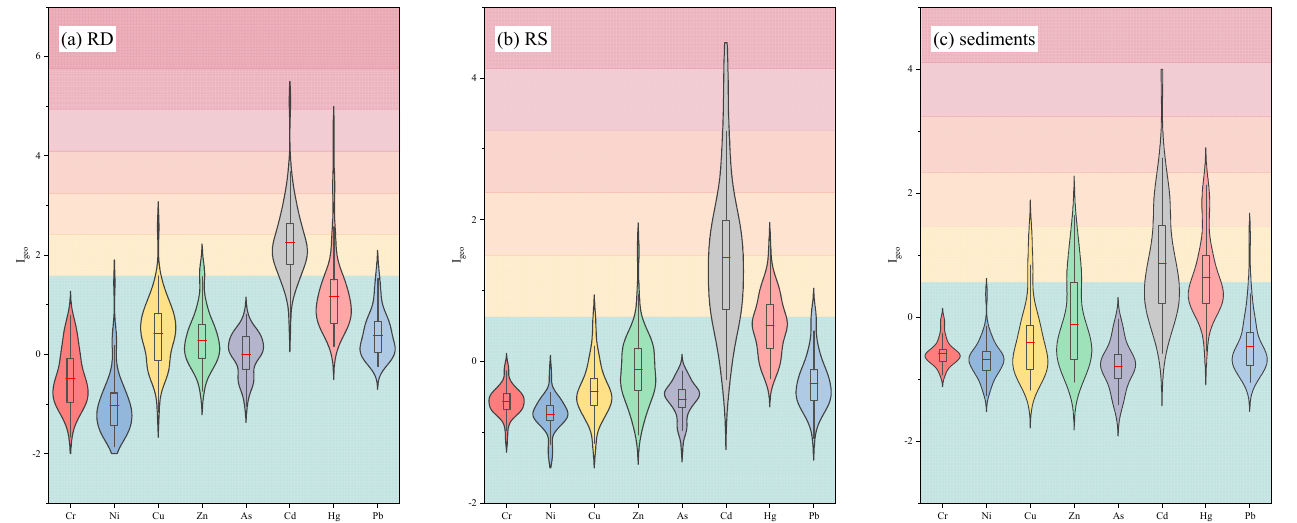
Figure 7. Violin plots of geo-accumulation index ( I geo ) for PTEs in road dust ( a ), roadside soils ( b ) and surface sediments ( c ) of Zhengzhou. The middle red lines represent the mean value. The ends of the box represent the 25th and 75th quantiles.